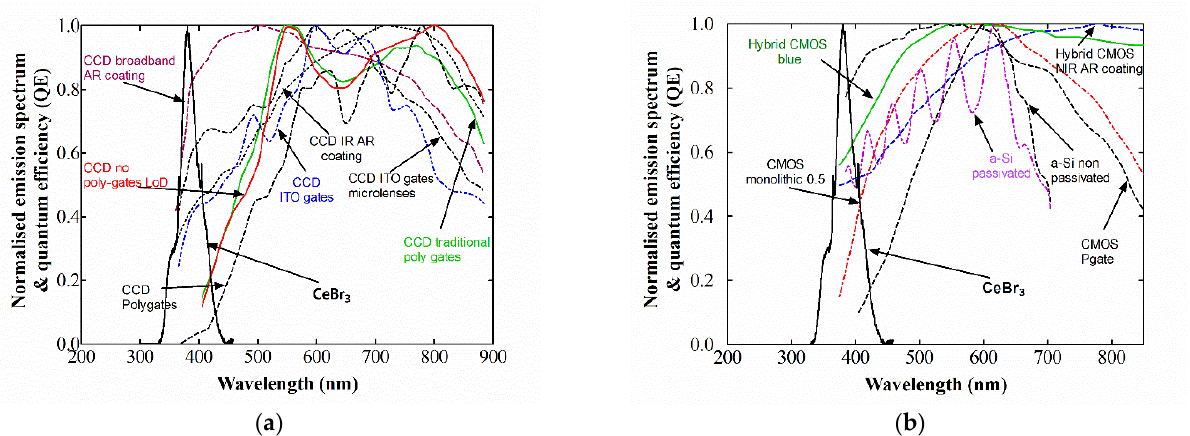
Figure 4. CeBr 3 spectral matching with: ( a ) charge-coupled-devices; ( b ) complementary metal- oxide